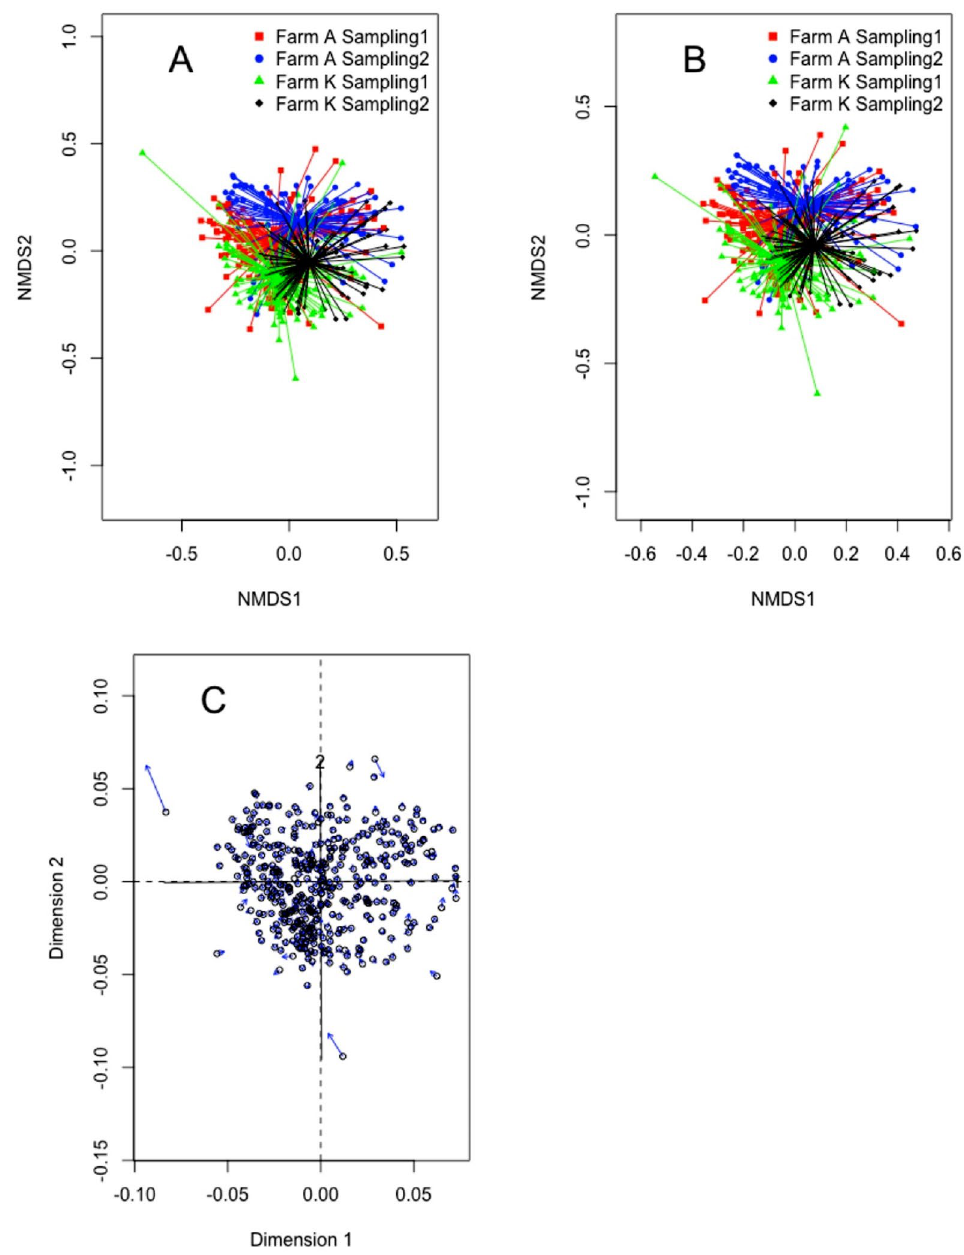
Figure 1. Non-metric multidimensional scaling (NMDS) plot of bovine quarter milk samples. ( A ) NMDS using Bray–Curtis dissimilarity matrix and ( B ) NMDS constructed using the Jaccard index dissimilarity matrix. ( C ) Procrustes analysis combining the NMDS results for Bray–Curtis and Jaccard index dissimilarity